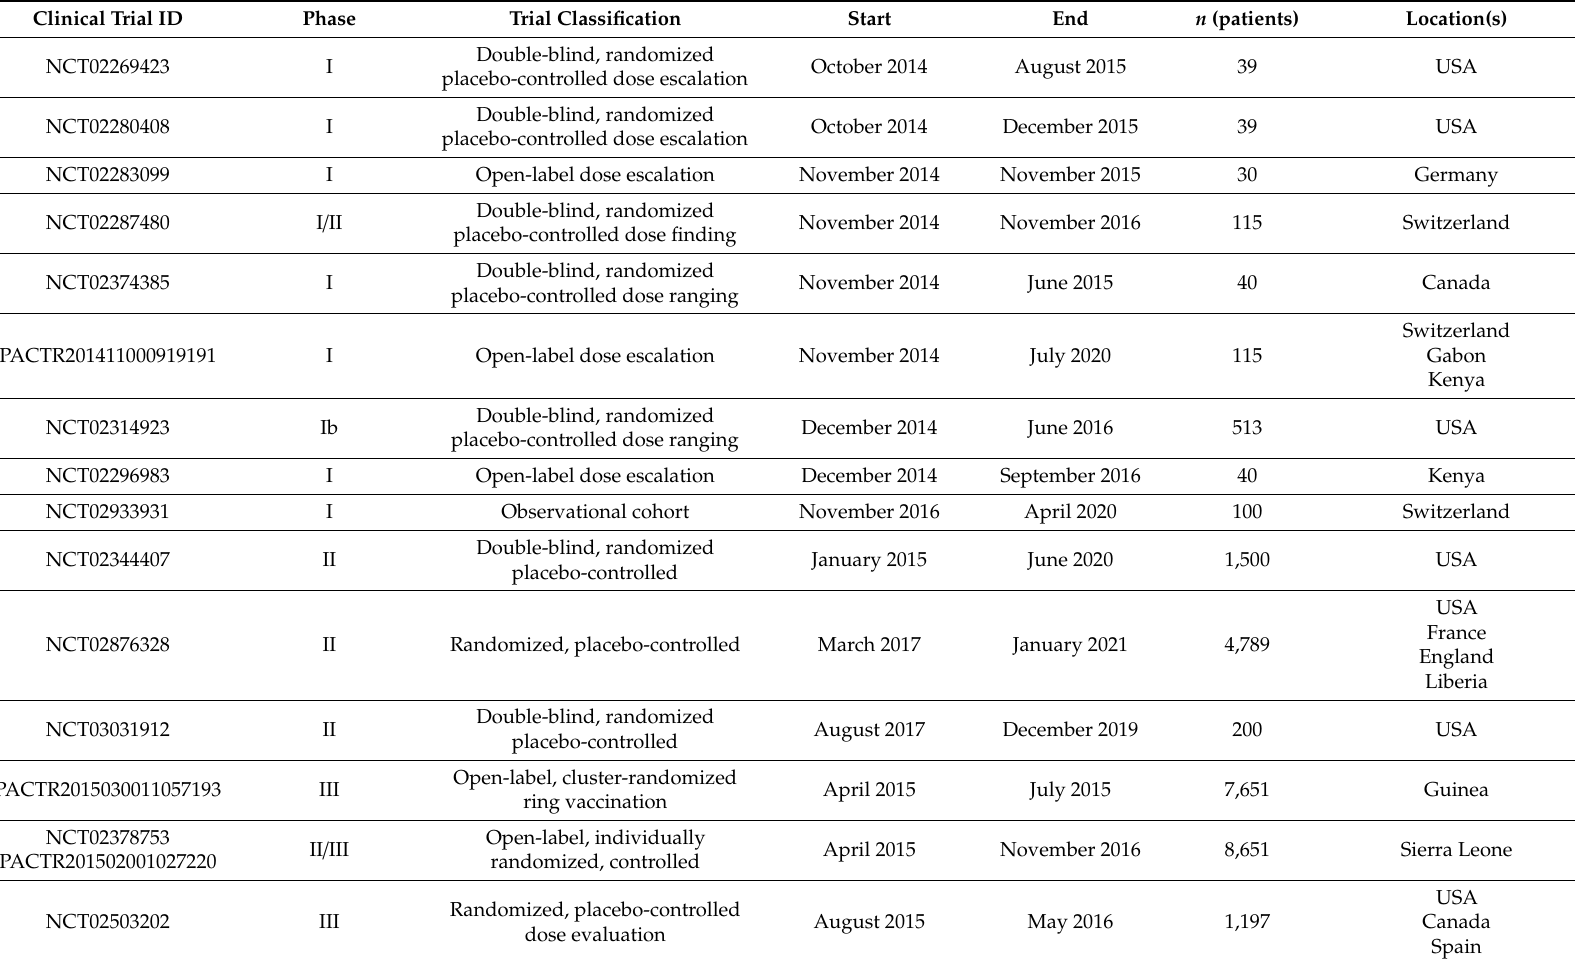
Table 2. rVSV-EBOV-GP clinical